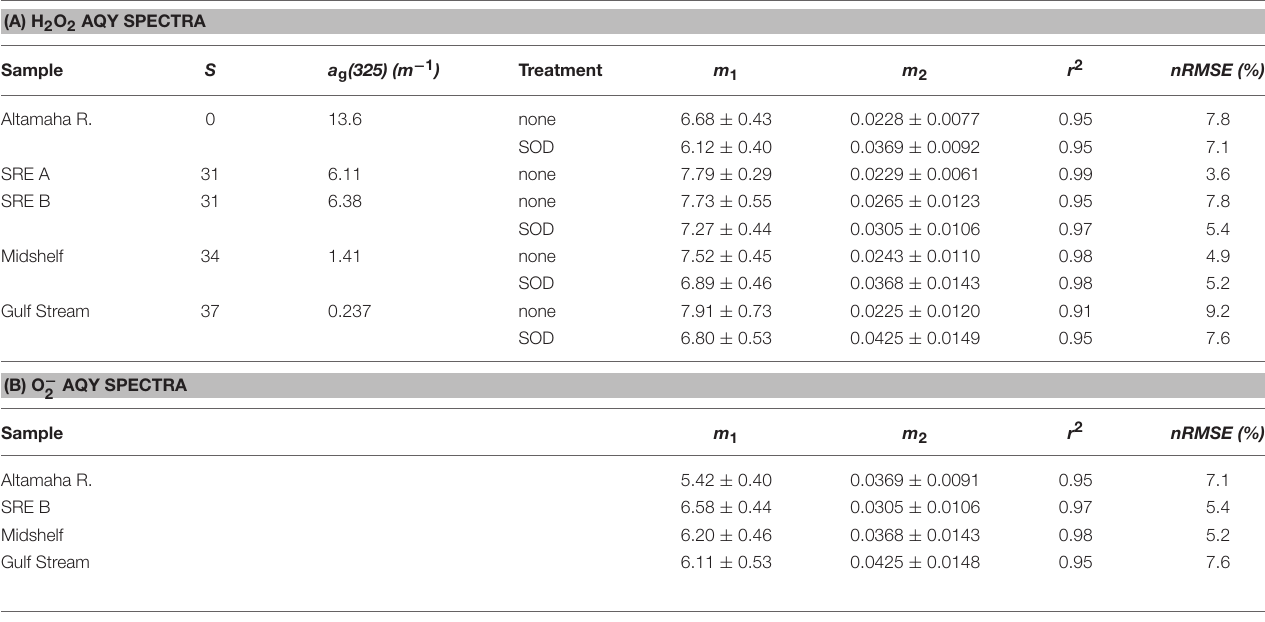
TABLE 1 | Fitting parameters ( m 1 and m 2 values ± their 95% confidence interval), salinity (S), and CDOM absorbance [ a g (325) (m − 1 )] for all samples used in AQY